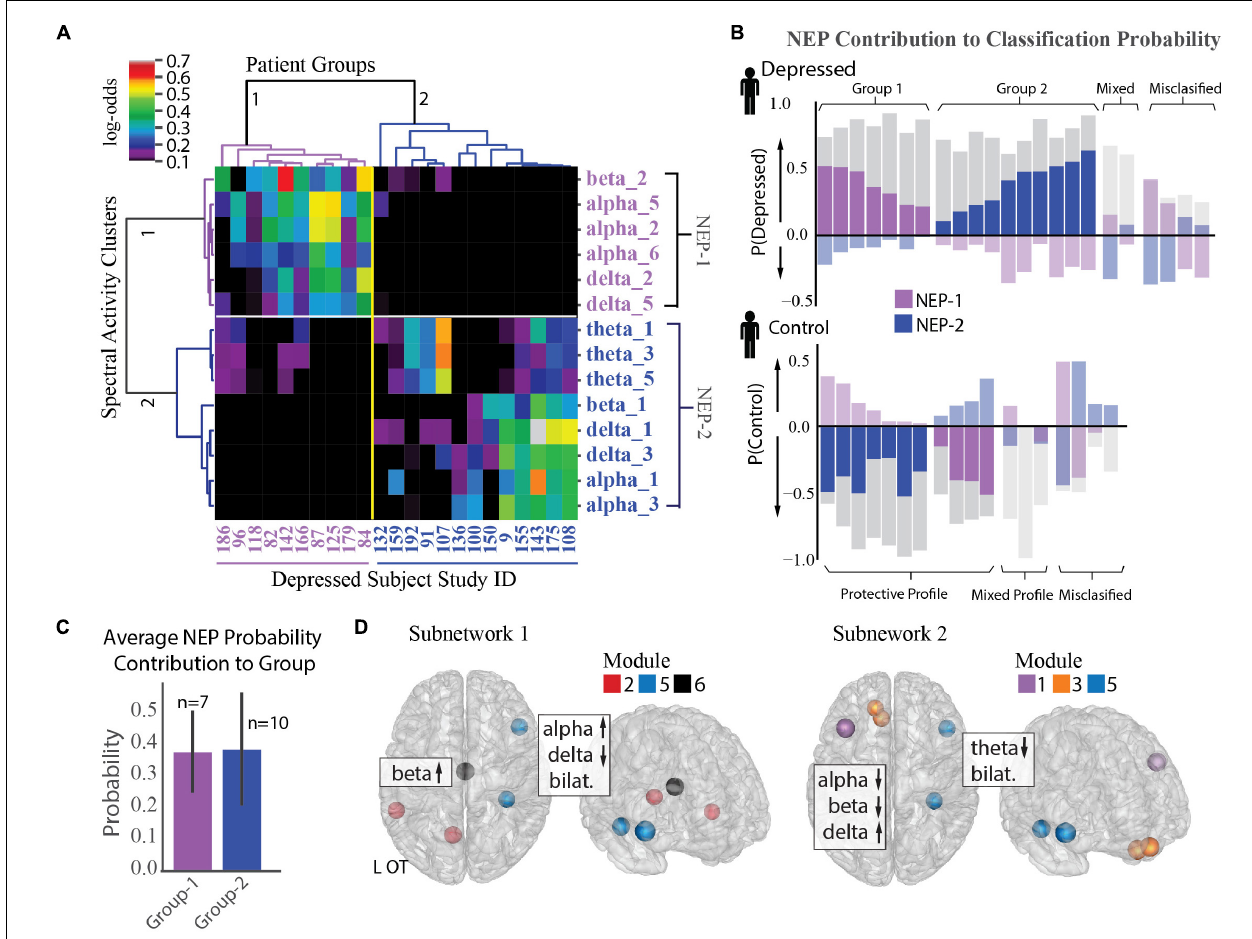
FIGURE 5 | Identification of two depression subnetworks. (A) Hierarchical clustering on log-odds of spectral-spatial features at the individual patient level showing 2 patient groups (horizontal groupings) and 2 network expression patterns (NEPs) (vertical groupings). Columns represent individual patients with patient study number shown at bottom, and rows represent spectral power across one frequency band and module (ex. alpha_1 = alpha power across module 1). Magnitude of log-odds represented by color of corresponding boxes (color-bar legend top right). Spectral-spatial features associated with NEP-1 represented in purple text and those associated with NEP-2 represented in blue text. (B) NEP probability contribution for the depressed group (top plot) and control group (bottom plot) derived from a sensitivity analysis where the probability of depression for each individual was calculated in total and with a perturbation where each NEP was held out. The probability difference was attributed to the presence of the NEP. This probability contribution is represented by the colored bars overlaid over each patient’s total probability of being depressed as derived from the machine learning classification model (gray bars, probability > 0.5 leads to classification of depression). The perturbations do not sum to produce the total classification probability; rather each quantifies the relative importance of that NEP toward depression. Bars in the positive direction indicates a positive contribution toward depression, and those in the negative direction indicate a protective contribution toward depression. Subjects where one of the two NEPs did not drive classification probability are shown in muted colors (mixed profile). Subjects classified incorrectly shown on far right of each plot (misclassified). (C) Mean probability contribution of each NEP to two patient groups is shown. NEP-1 (purple bars) contributed most strongly to the probability of depression in the first group (mean = 38% probability contribution, SD = 0.13) and NEP-2 (blue bars) contributed most strongly to a second group (mean = 39% probability contribution, SE = 0.18). Number of participants who exhibit each NEP shown above each bar. Error bar = standard deviation. (D) Direction of activity and spatial distribution of activity changes within NEP shown on glass-brain in several orientations. Hubs for each module within the NEP are designated by hub